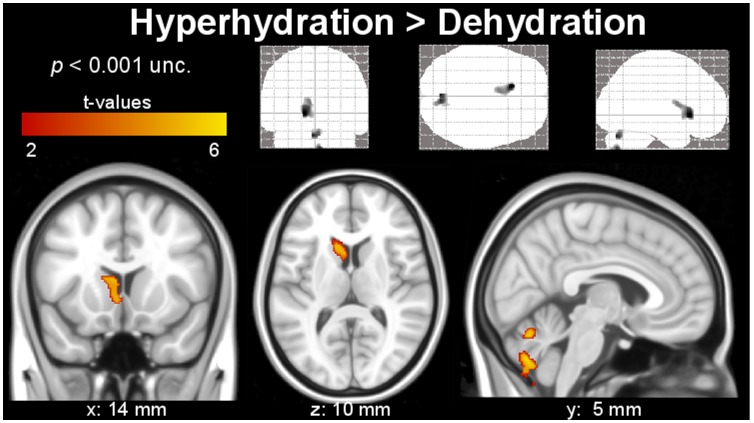
Segmented clusters of the gray matter with significant extension during hyperhydration compared to dehydration in caudate nucleus and cerebellar regions (indicated by the color code) obtained with VBM.The upper row shows the results as grayscale Maximum Intensity Projection onto the standard SPM glass brain in coronal, axial and sagittal view.